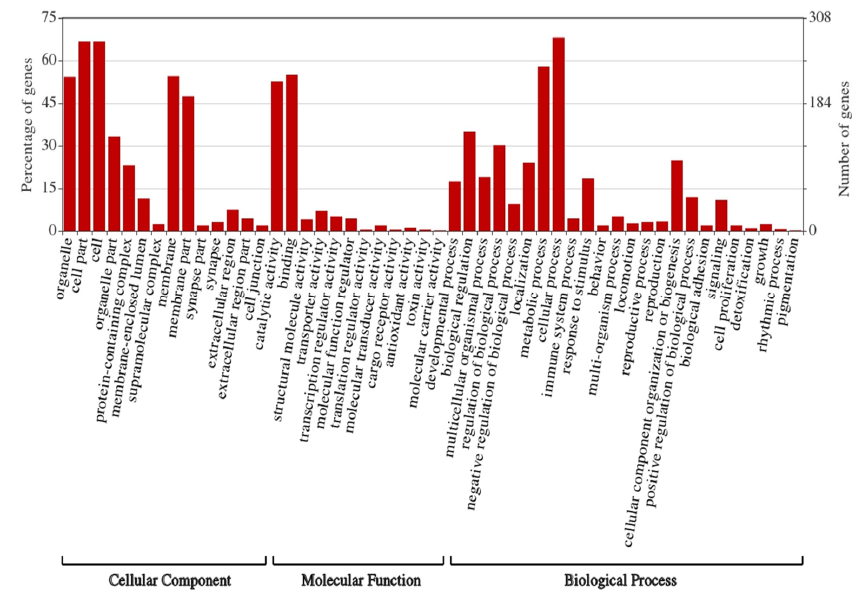
Figure 5. Gene ontology (GO)-derived biological processes related to genes targeted by differen- tially expressed miRNAs in partially fed B. burgdorferi -infected salivary glands relative to partially fed uninfected salivary glands from Ixodes scapularis ticks.